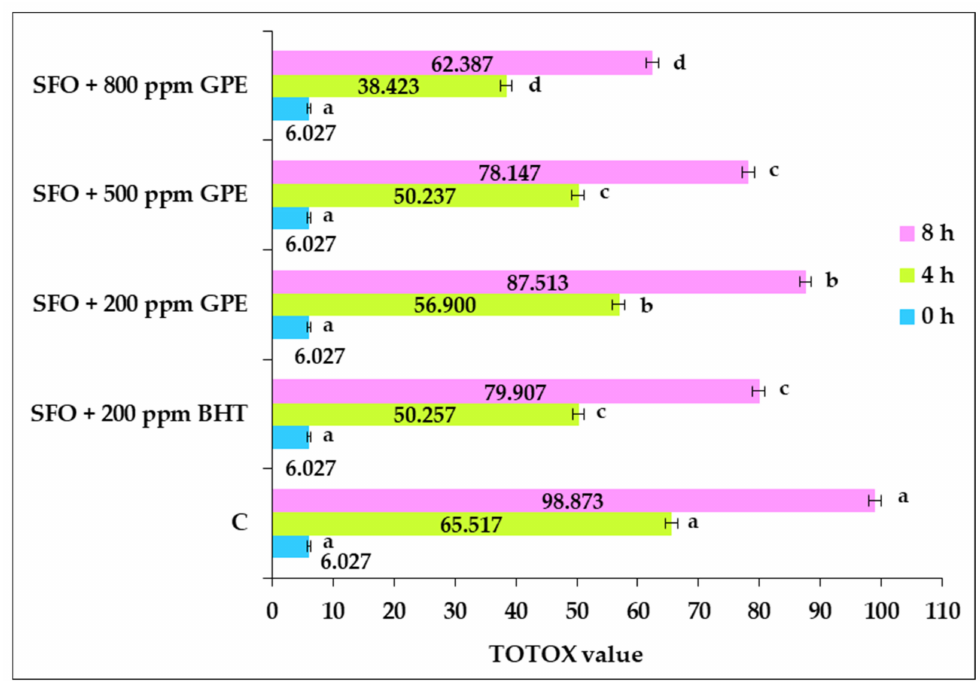
Figure 3. Effect of sunflower oil supplementation with grape pomace extract and BHT on the TOTOX value during exposure to heat. The values for bars with different letters are significantly different from each other (one-way ANOVA, p <